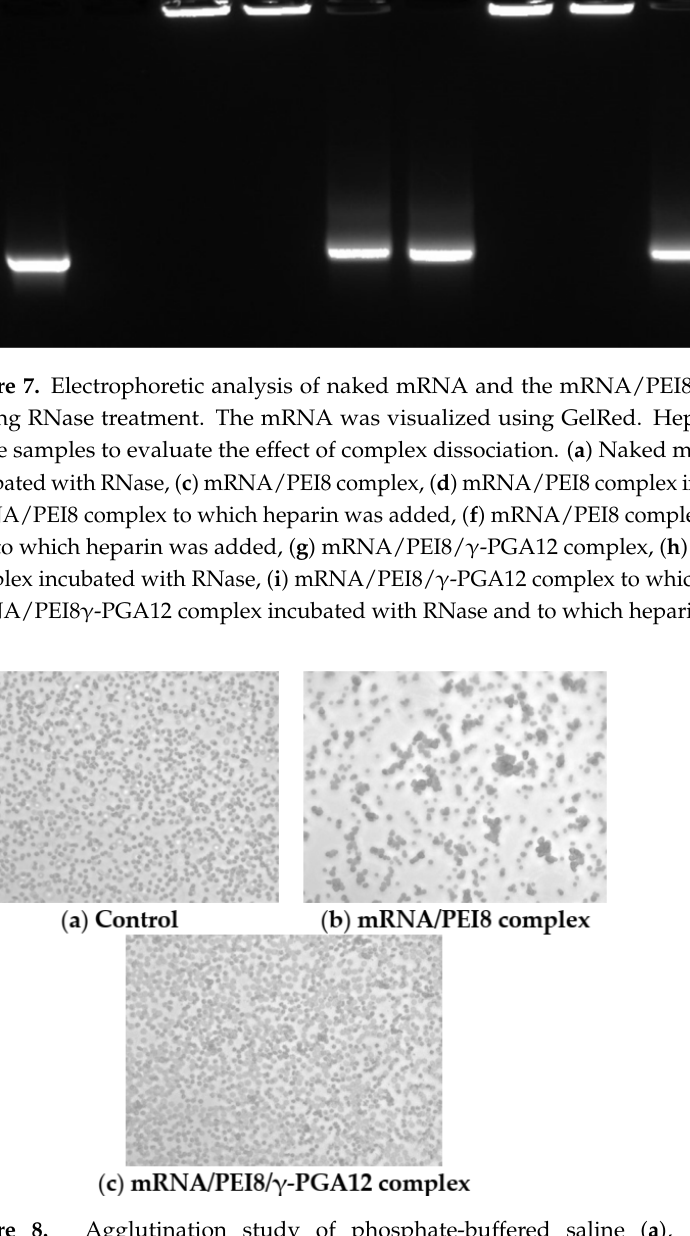
Figure 8. Agglutination study of phosphate-buffered saline ( a ), mRNA/PEI8 ( b ), and mRNA/PEI8/ γ -PGA12 complex ( c ) with erythrocytes. After the complexes were added to the erythrocytes, agglutination was observed by phase-contrast microscopy (400 ×